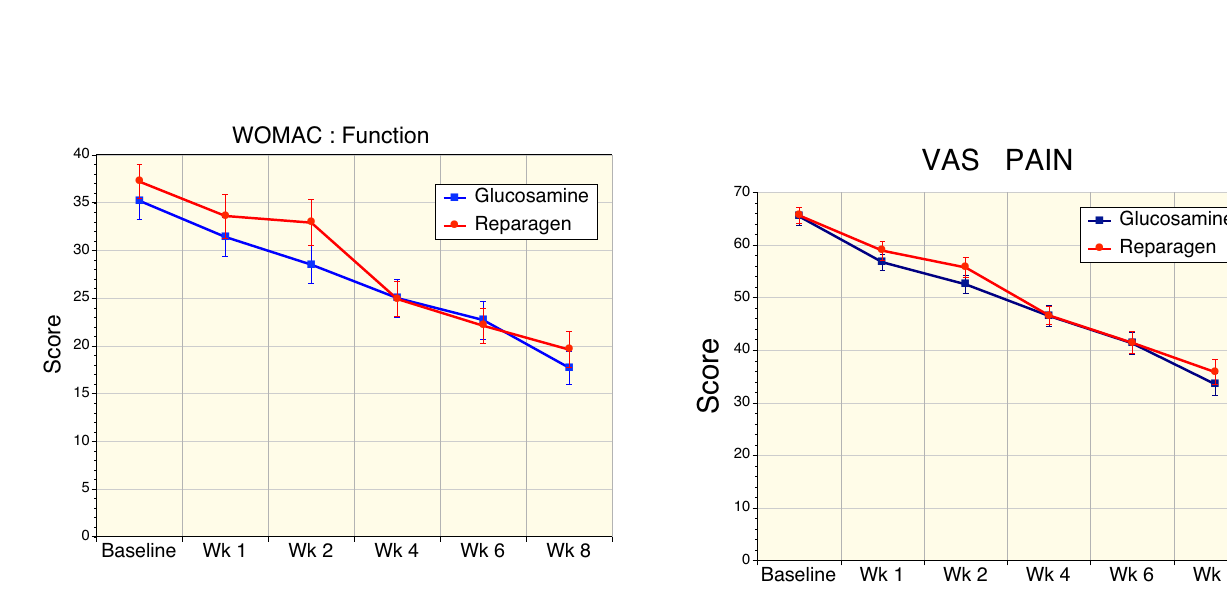
Figure 6 Sequential changes in total WOMAC scores (pain, stiffness and function) for reparagen (red, n = 48) and glucosamine (blue, n = 47). Both treatments resulted in a significant reduction in baseline WOMAC total scores from week 1 (reparagen p < 0.01, glucosamine p < 0.05), with further improvements with sustained administration (p <